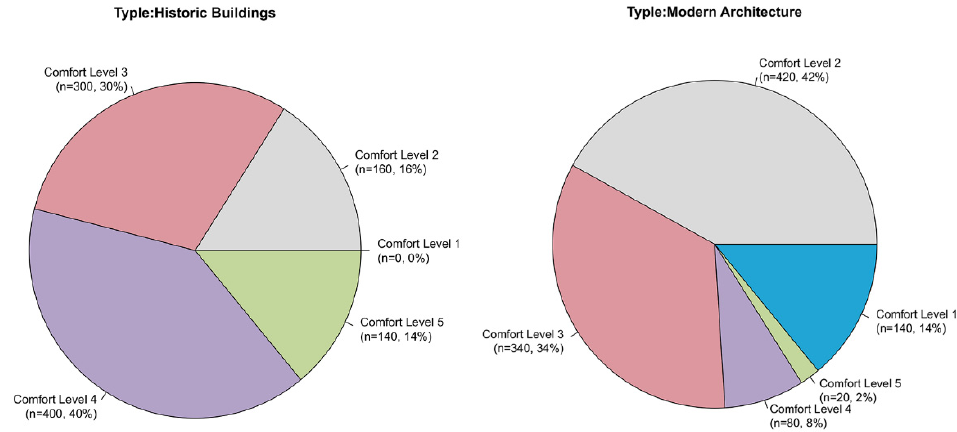
Figure 4. Percentage of comfort rating of historic buildings and modern buildings.